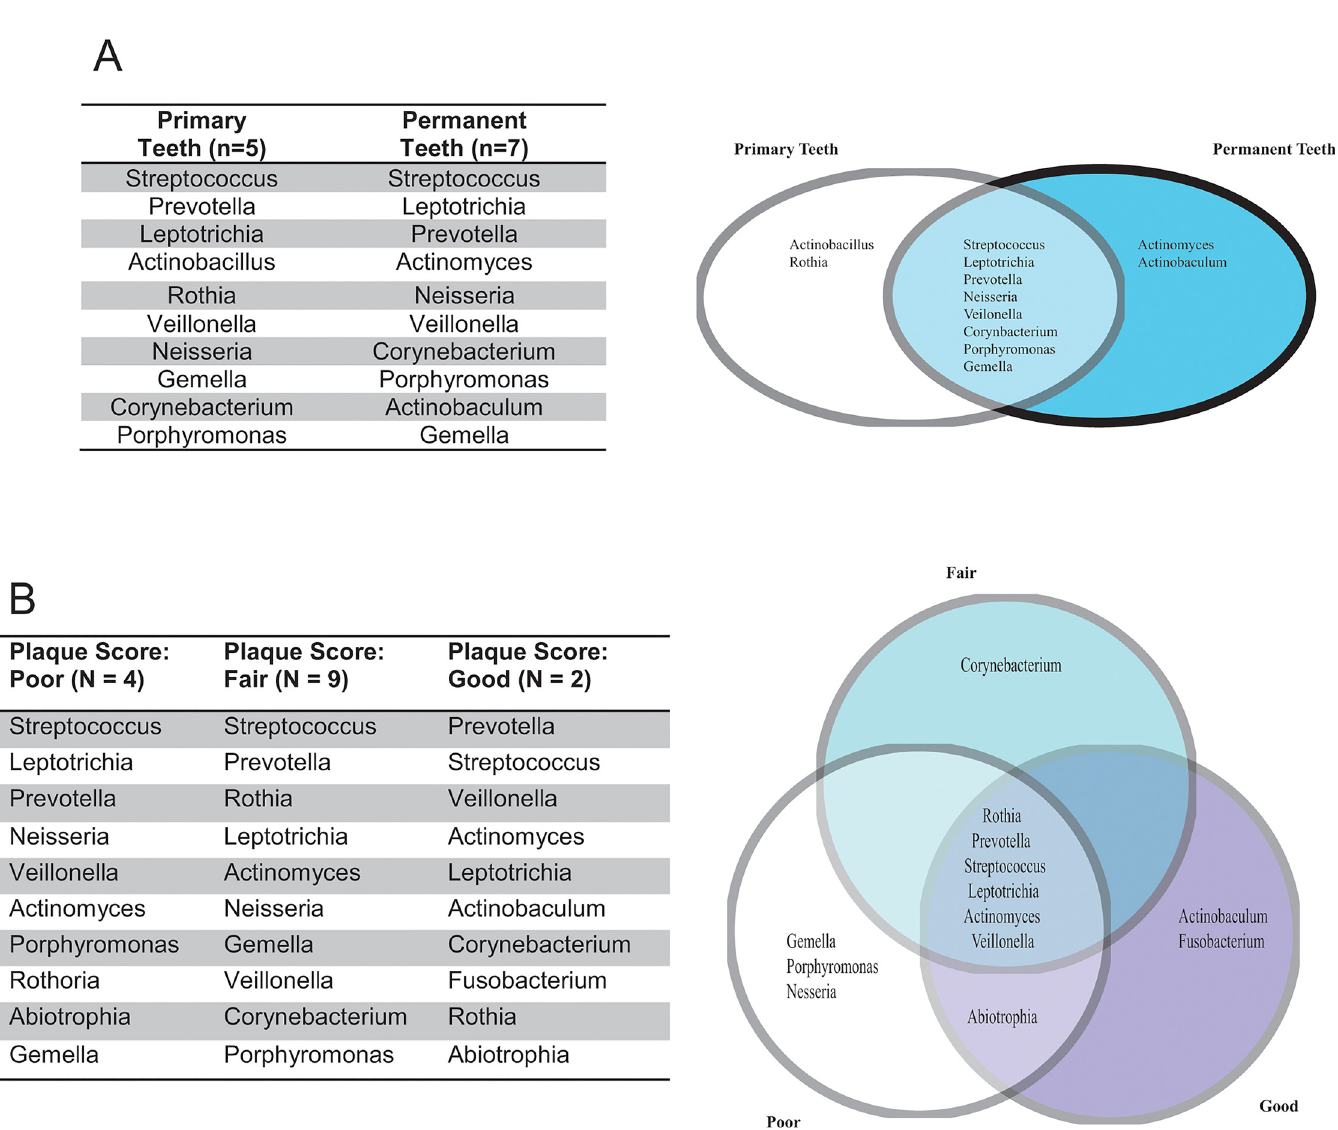
Fig 3. Most abundant OTUs. Relative OTU abundance was summed for primary versus permanent teeth and plaque score. Multiple OTUs may be generated for the same genera, due to the clustering method employed by QIIME. Unique genera consist of OTUs with identical genera assignments, which were summed for each patient group to provide a total abundance for each unique genus. The abundance data was normalized and ranked to identify the ten most abundant genera for each group. Genera identified in only primary or permanent teeth were present in both patient groups, but at lower relative